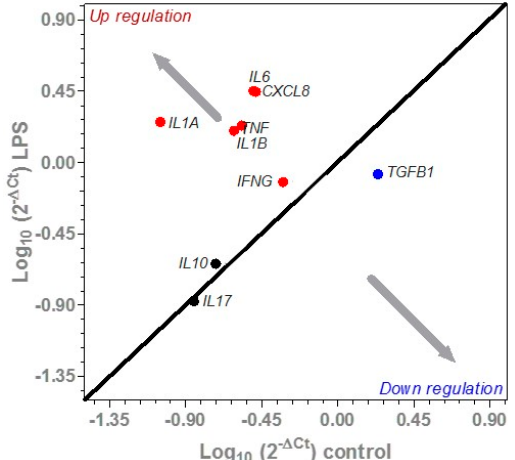
Figure 4. Differences in the expression of a selected panel of cytokine genes between unchallenged and lipopolysaccharide (LPS) challenged ex vivo colonic tissues. The red dots represent significant upregulated genes ( p < 0.05), the blue dot represents a significant downregulated gene ( p < 0.05) and the black dots represent genes not affected by LPS ( p > 0.05).